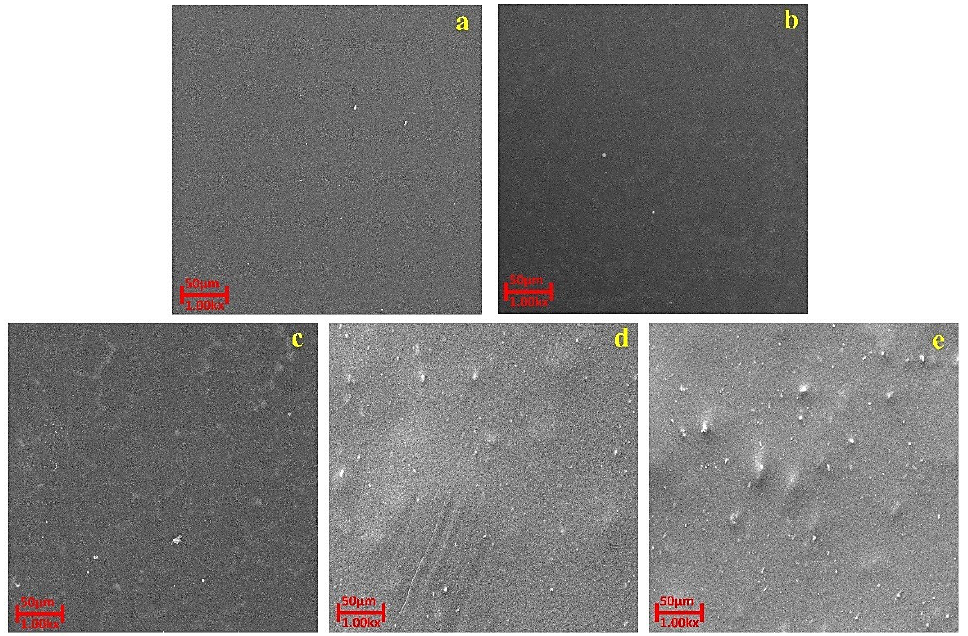
Figure 9. Surface topography SEM images of ( a ) MP0 ( b ) MC1 ( c ) MC4 ( d ) MC7 ( e ) MC10. Sample codes are summarized in Table 1.